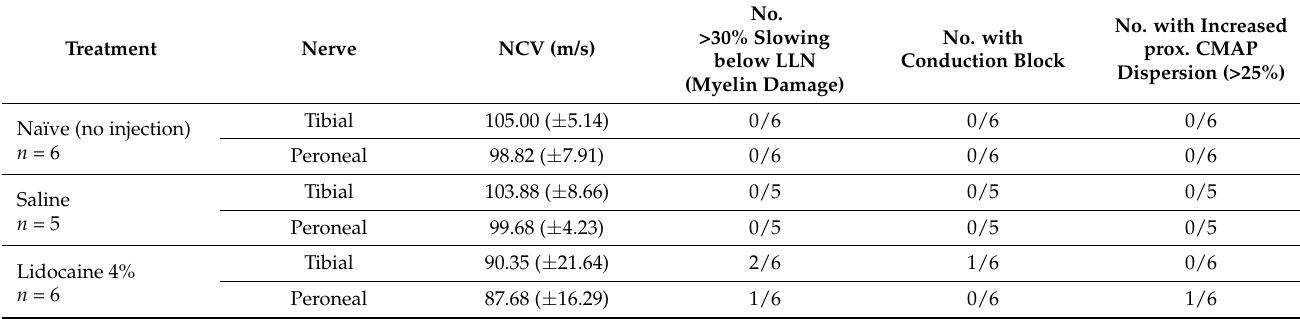
Table 1. Summary of electrophysiological findings for sciatic motor nerve myelin